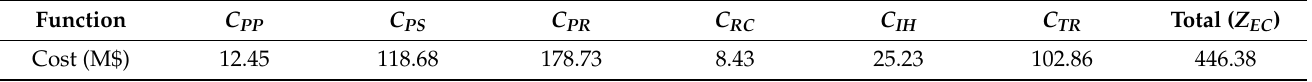
Table 9. Consumed raw materials for the production of the different fertilizers